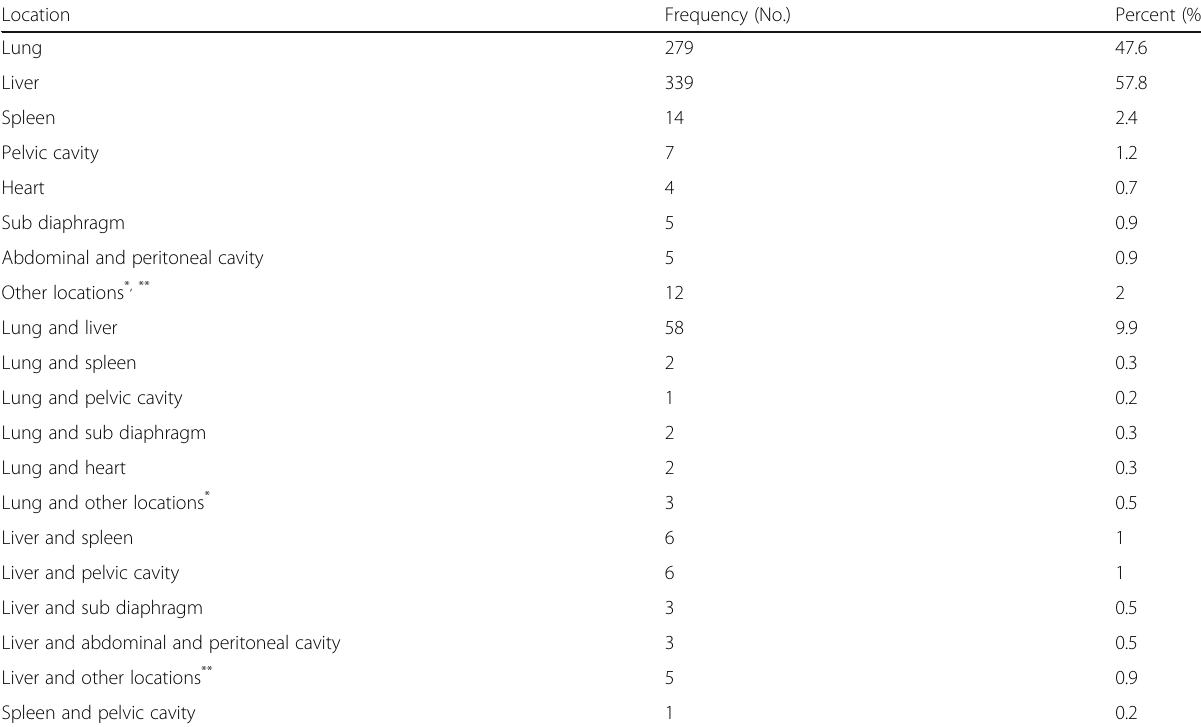
Table 1 location of hydatid cysts in CE cases in southwestern Iran, based on hospital record, during a 15-year period (2004 – 2018) Location Frequency (No.) Percent (%) Lung 279 47.6 Liver 339 57.8